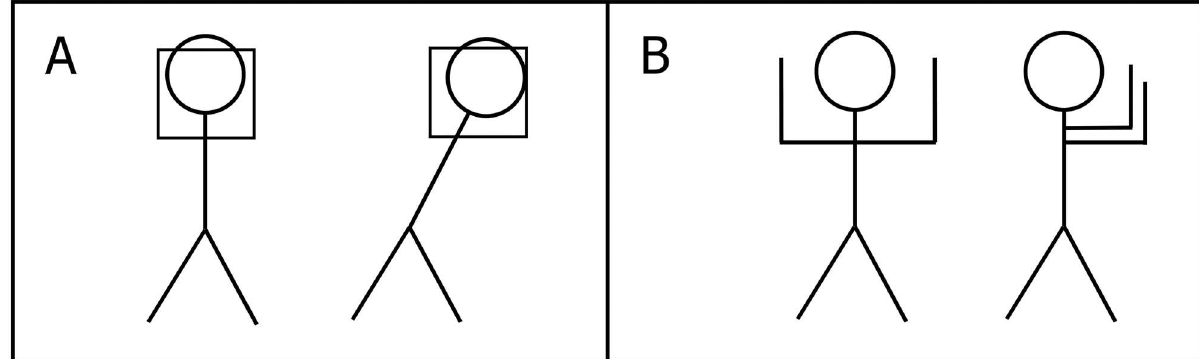
Fig 4. Rotating the body with the arms in the position of a right